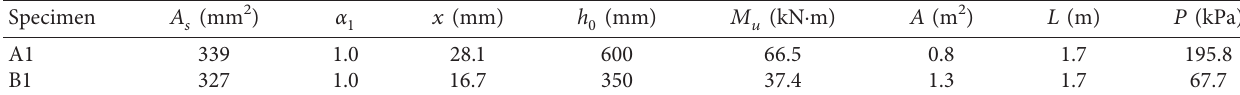
Table 5: Parameters in formula (6).